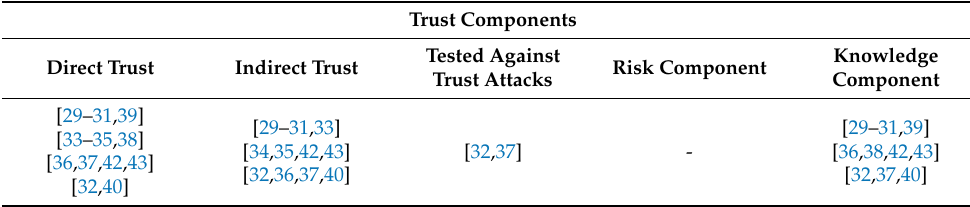
Table 3. Research on trust in Smart Grid categorized by trust components.